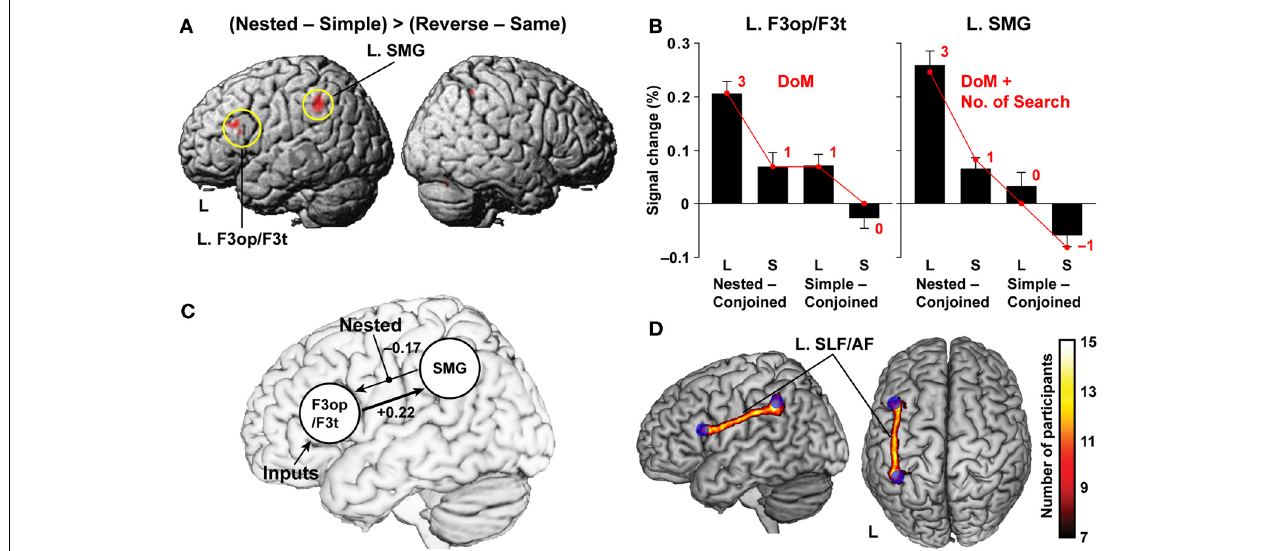
FIGURE 5 | Functional and anatomical evidence of a syntax-related network. (A) Regions identified by the (Nested − Simple) > (Reverse − Same) contrast (see Figure 4 ). Activations were projected onto the left (L) and right lateral surfaces of a standard brain. (B) Percent signal changes for Nested − Conjoined and Simple − Conjoined in the L. F3op/F3t and L. SMG. Overlaid red dots and lines denote the values fitted with the estimates (digits in red) for the best models: DoM for the L. F3op/F3t and “DoM + number of Search” for the L. SMG. (C)